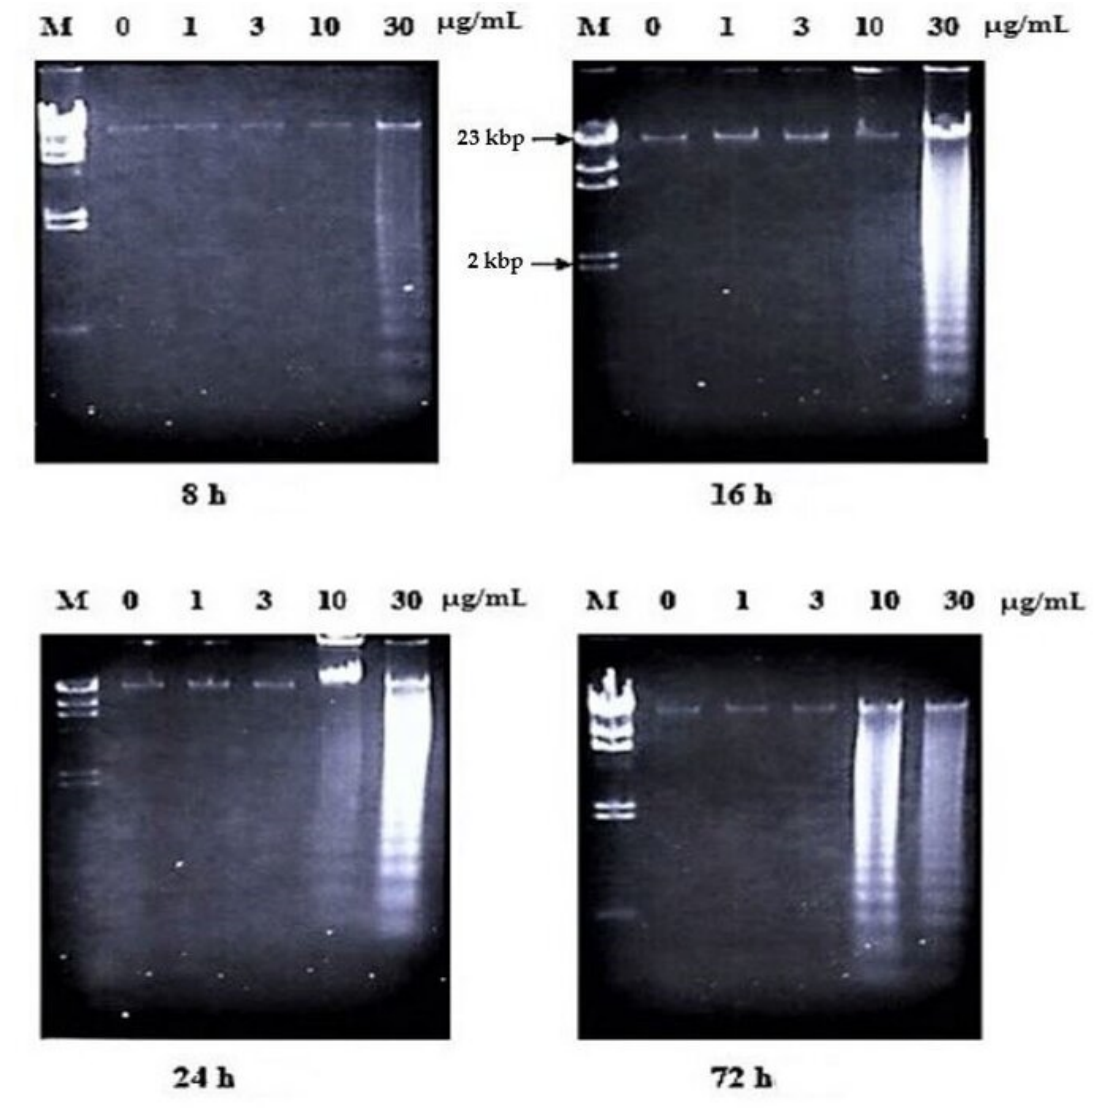
Figure 3. Effects of different concentrations of nordamnacanthal at different hours on DNA fragmentation in CEM-SS cells. Lane M: Marker (HindIII digest of lambda DNA).